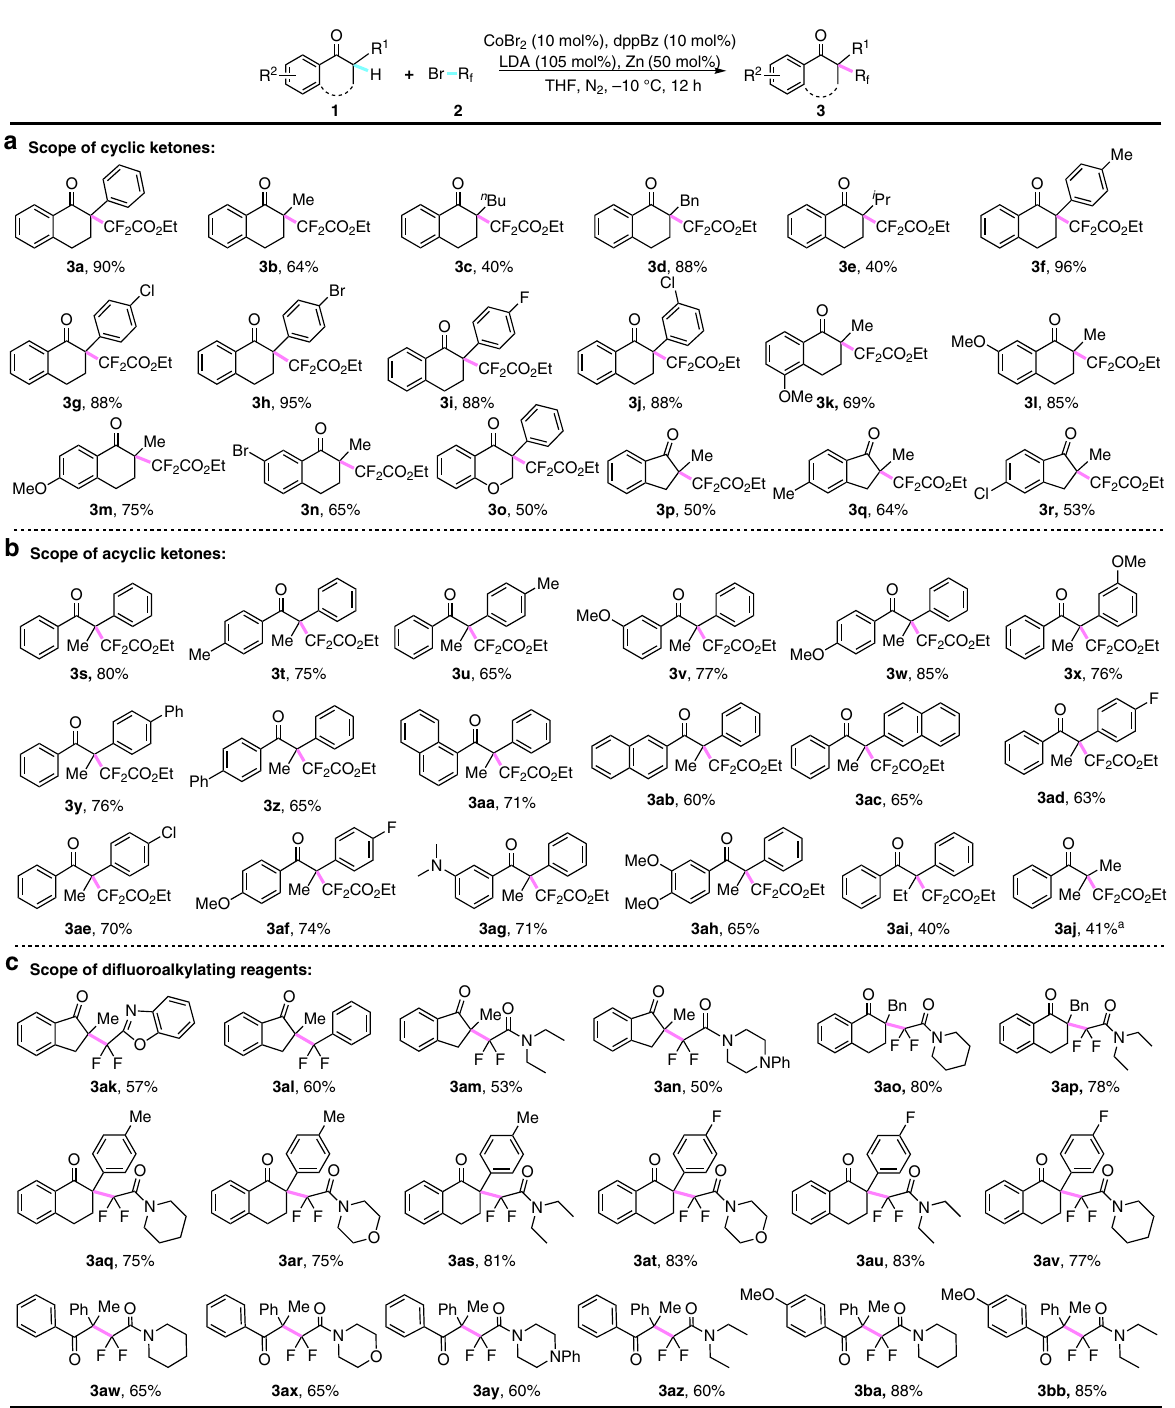
Fig. 2 Cobalt-catalyzed di fl uoroalkylation of aryl ketones. a Scope of cyclic ketones. b Scope of acyclic ketones. c Scope of di fl uoroalkylating reagents. Conditions: 1 (0.2 mmol, 1.0 equiv), 2 (3.0 equiv), CoBr 2 (10 mol%), dppBz (10 mol%), LDA (105 mol%), Zn (0.5 equiv), THF (2.0 mL), − 10 °C, 12 h, under N 2 atmosphere. a Conditions: 20 mol% of CoBr 2 and 20 mol% of dppBz were used. dppBz =